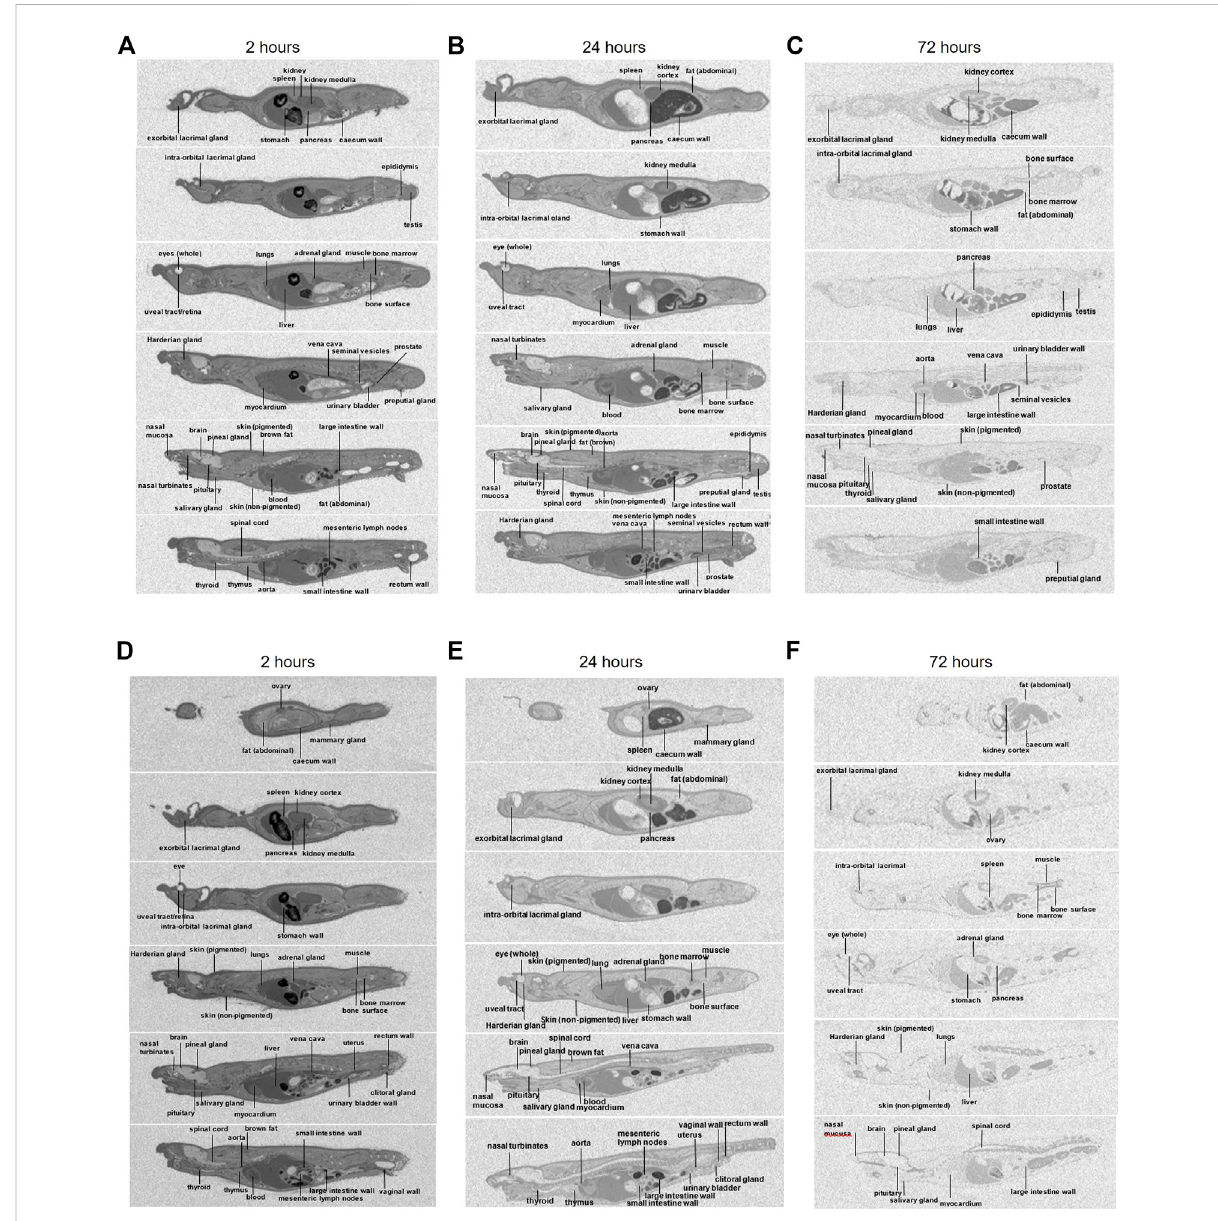
FIGURE 5 Whole body autoradiography. Distribution of radioactivity at 2, 24 and 72 h following a single oral administration of [ 14 C]-zapnometinib (30 mg/kg) to male (A – C) and female (D – F) partially pigmented rats (Group 3). Whole body autoradiogram for one representative animal is